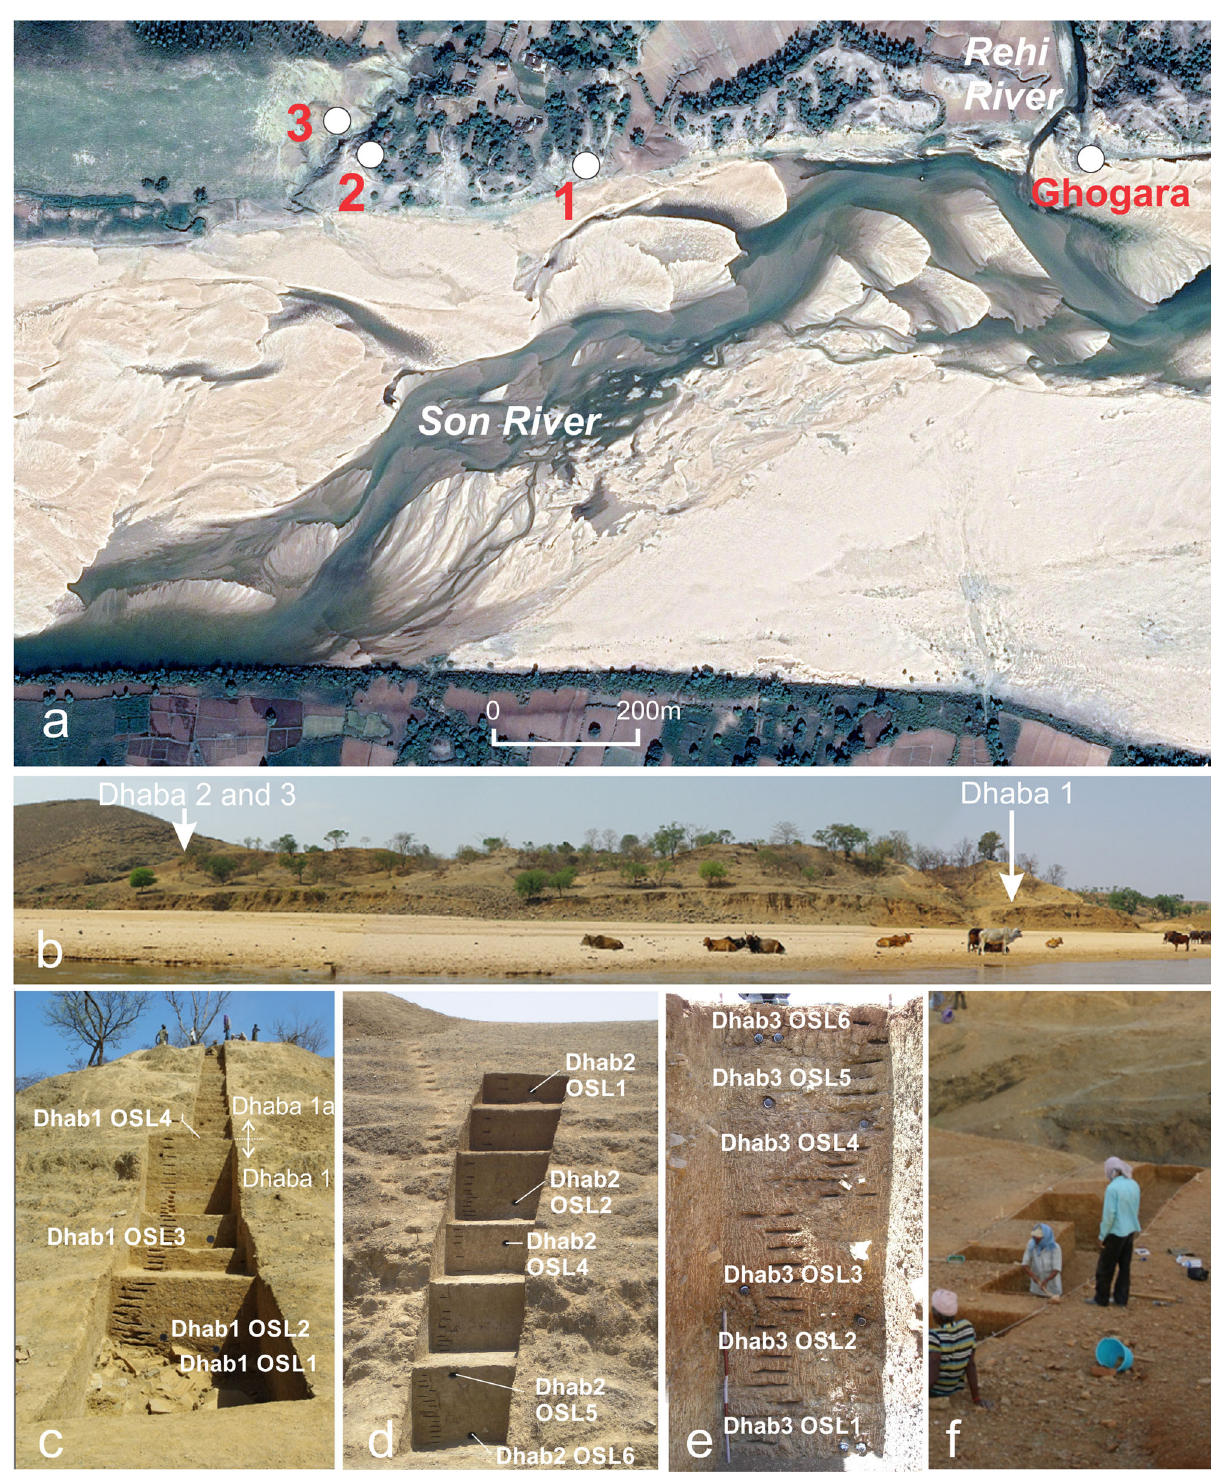
Fig. 2 Dhaba site location and excavation sections. a Satellite image of the Son River showing the Rehi con fl uence and location of the Dhaba excavations (image courtesy of GoogleEarth, image date 11/26/2015, Image © 2019 CNES/Airbus). b View of the Dhaba locality from the Middle Son river bed (photo Courtesy of Michael Haslam). c Dhaba 1 trench (below), Dhaba 1A trench (above), and locations of IRSL samples. d Dhaba 2 trench showing IRSL sample locations. e Dhaba 3 section showing IRSL sample locations. f View of Dhaba 3 trench during